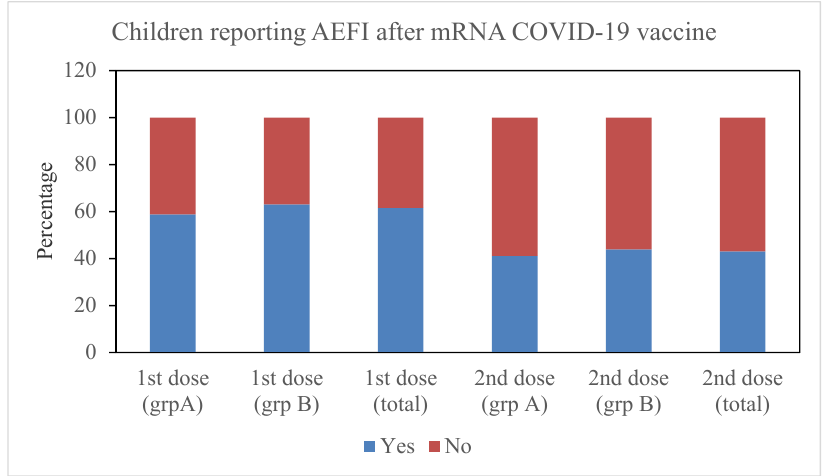
Figure 1. Percentage of children reporting AEFI after the first and second doses of vaccine. Table 2. Characteristics of children reporting AE after first and second dose of Pfizer-BioNTech’s m-RNA COVID-19 vaccine in group A (5–11 years) and group B (12–17 years).